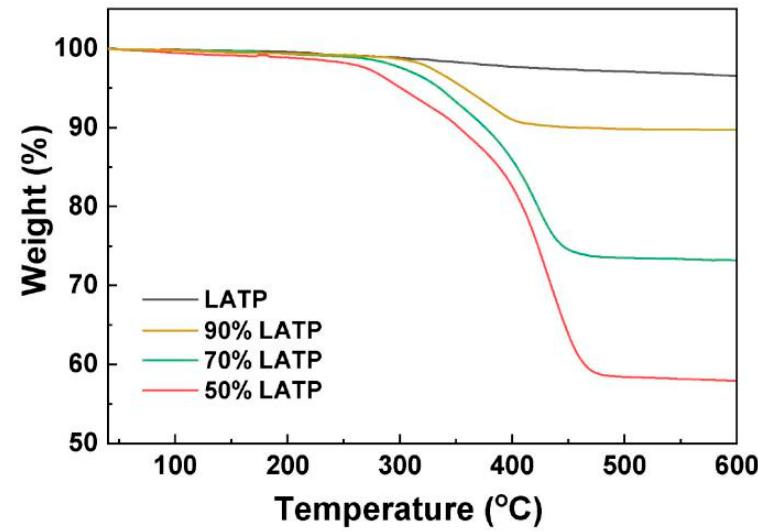
Figure 6. Thermogravimetric analysis curves of composite solid electrolytes with different content of LATP.